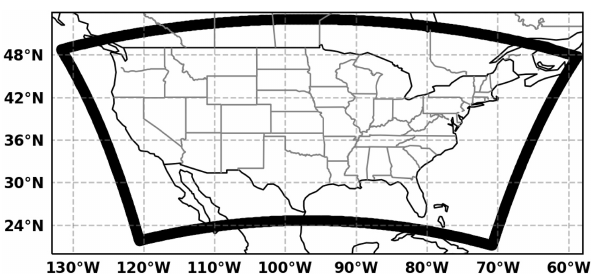
Figure 1. NAQFC CONUS domain (outlined in bolded black). This figure is plotted using cartopy https://scitools.org.uk/cartopy/docs/ latest/ (last access: February 2021), which uses the national and state border information from http://www.naturalearthdata.com/ (last access: February 2021). Please note that the above figure con- tains incomplete US state